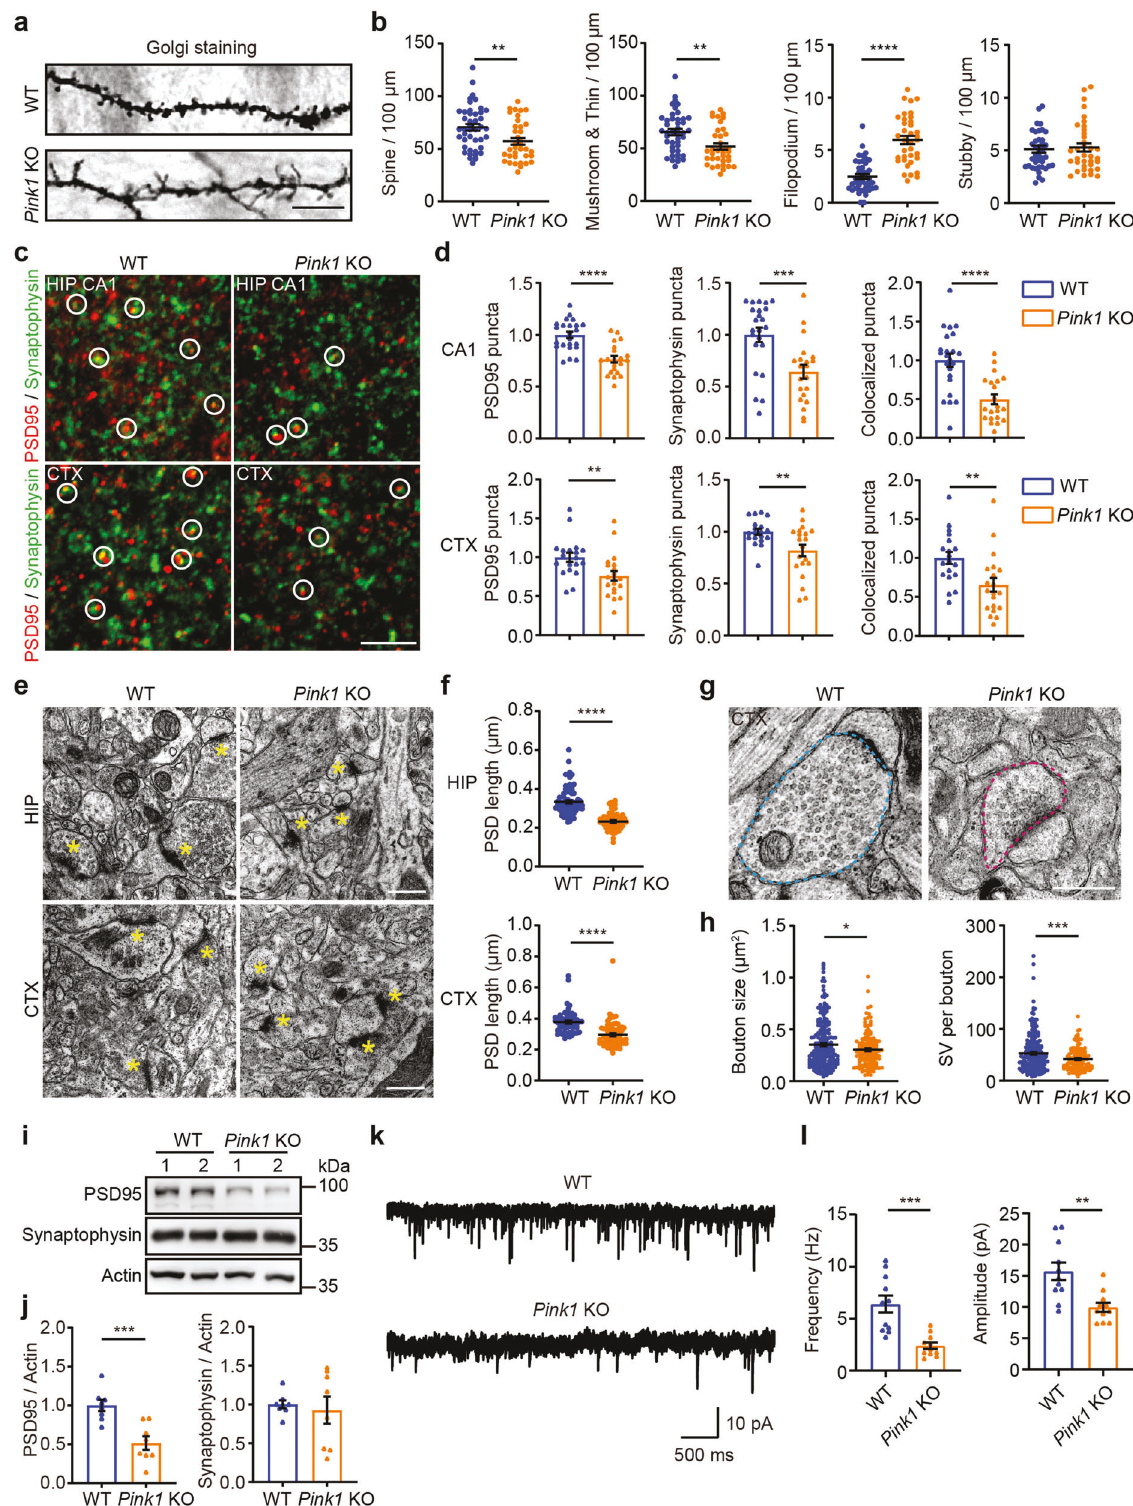
mitochondrial fi ssion. 5,8 To explore the mechanism of PINK1 in regulating synapse maturation and plasticity, we looked into PINK1 substrate Drp1 S616 that control mitochondrial dynamics. Phosphor-Drp1 S616 levels were greatly reduced in hippocampal